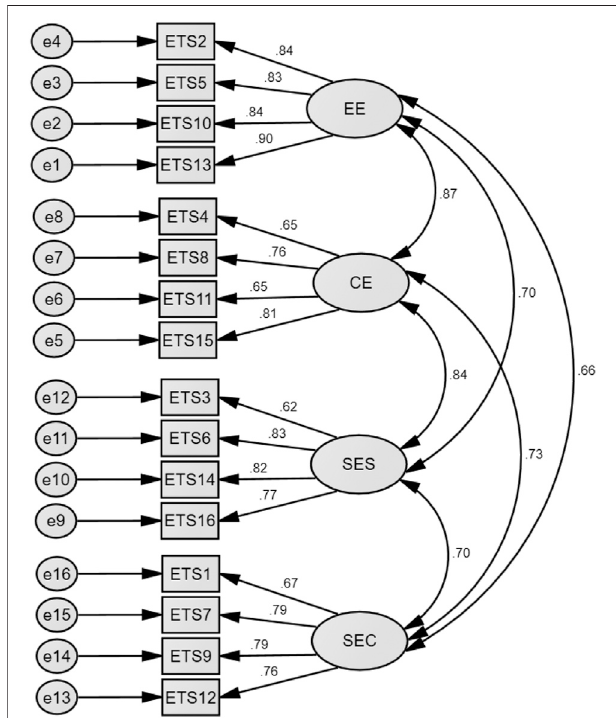
FIGURE 1 | Con fi rmatory factor analysis for the initial 16-item model of the